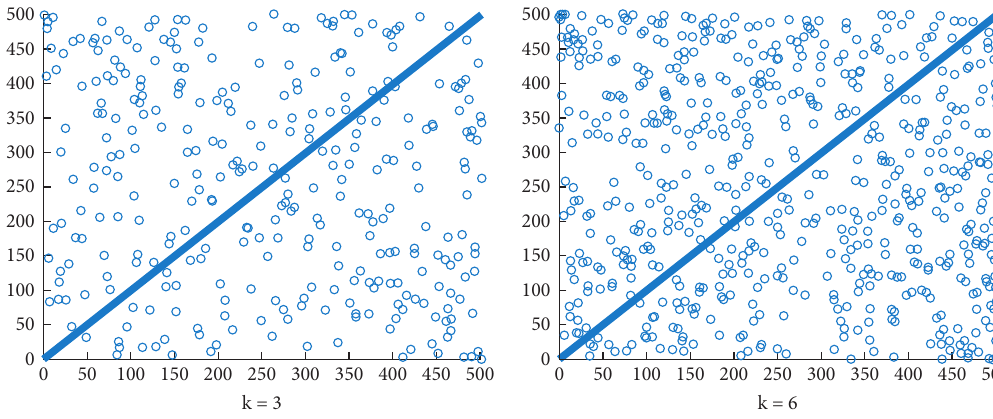
Figure 4: Small world network with different k